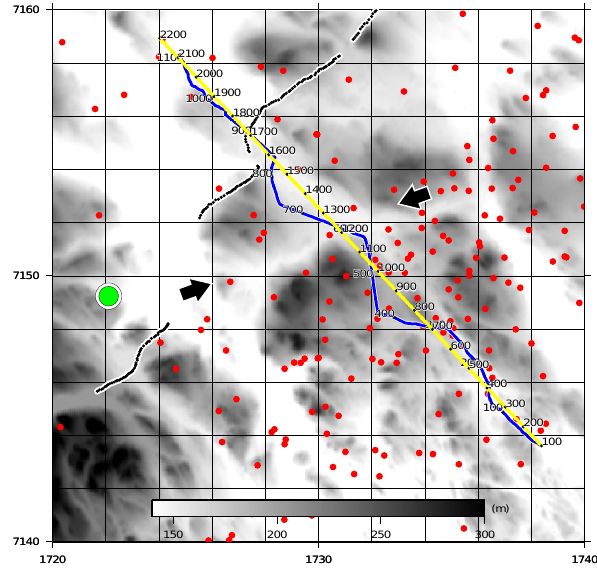
Fig. 6. CDP stacking line (yellow) and receiver line (blue) plotted on the topographic map. CDP and station numbers are shown in black. Black curve marks the mapped Burtr¨ask end-glacial fault. Arrows indicate a substantial topographic low that crosses the CDP stacking line at about CDP 1200. Green circle represents a nickel deposit. Red dots show locations of earthquake epicenters from single event